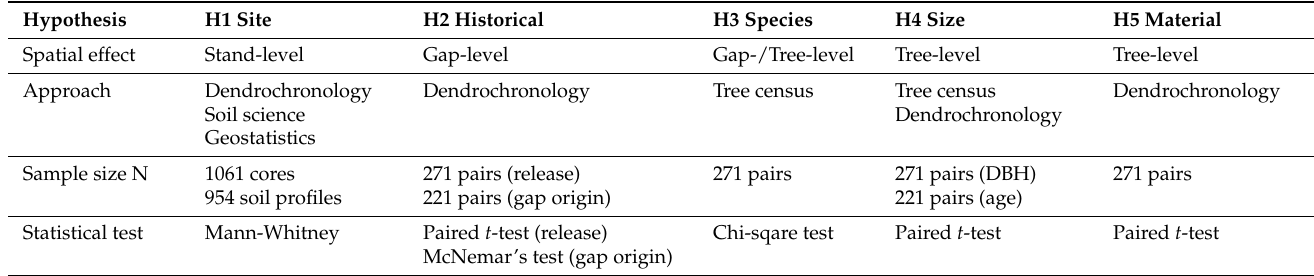
Figure 2. General conceptual model including relations between individual hypotheses. Table 1. A list of hypotheses, including analyses and data sets